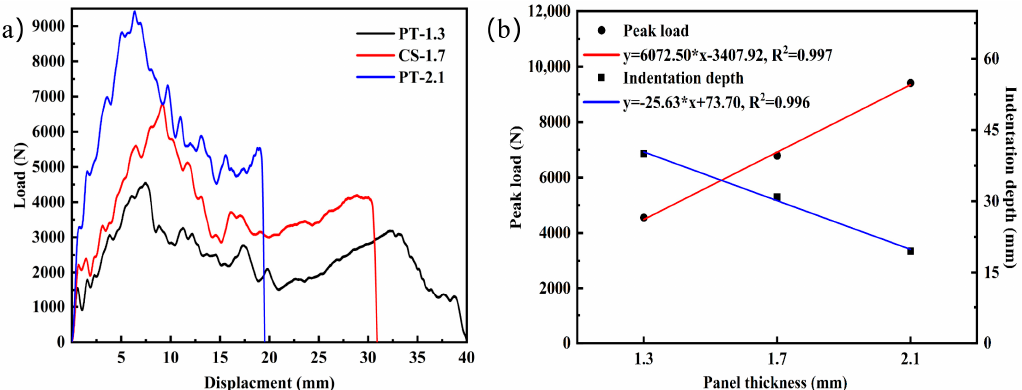
Figure 9. Mechanical response at different panel thicknesses: ( a ) Load-displacement curves; ( b ) Linear fitting diagram of peak load and indentation depth under different panel thicknesses.